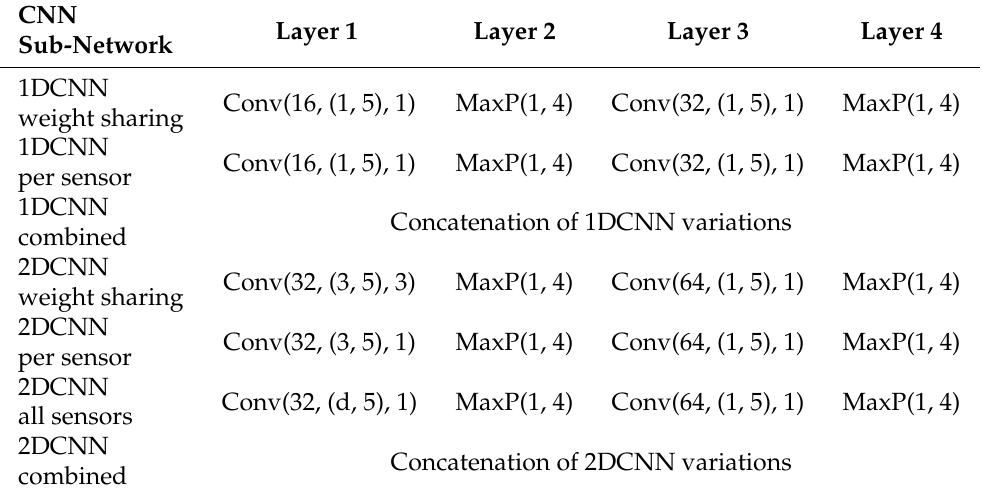
Table 1. Details of layers used on different CNN sub-networks. Recall that the convolutions named weight sharing use the same kernels for all the sensors and signals, while the convolutions named per sensor use independent kernels for each